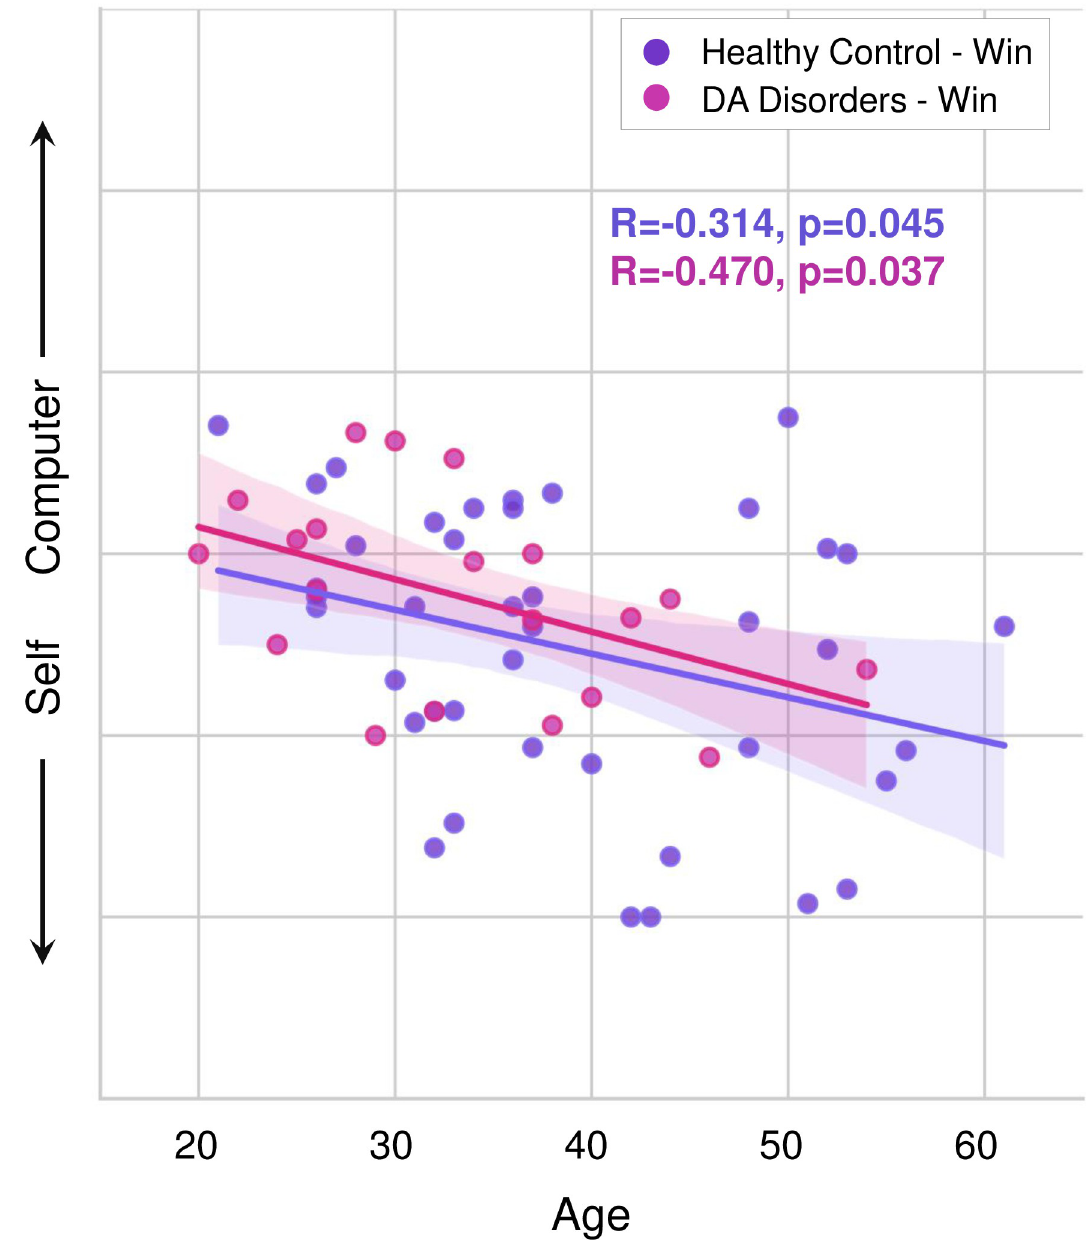
Fig 3. Higher positive feedback-dependent self-agency increases with age across all groups. Agency ratings plotted following positive-win feedback against age in healthy control subjects (N = 50, purple) and subjects with depression and anxiety (DA) disorders (N = 20,